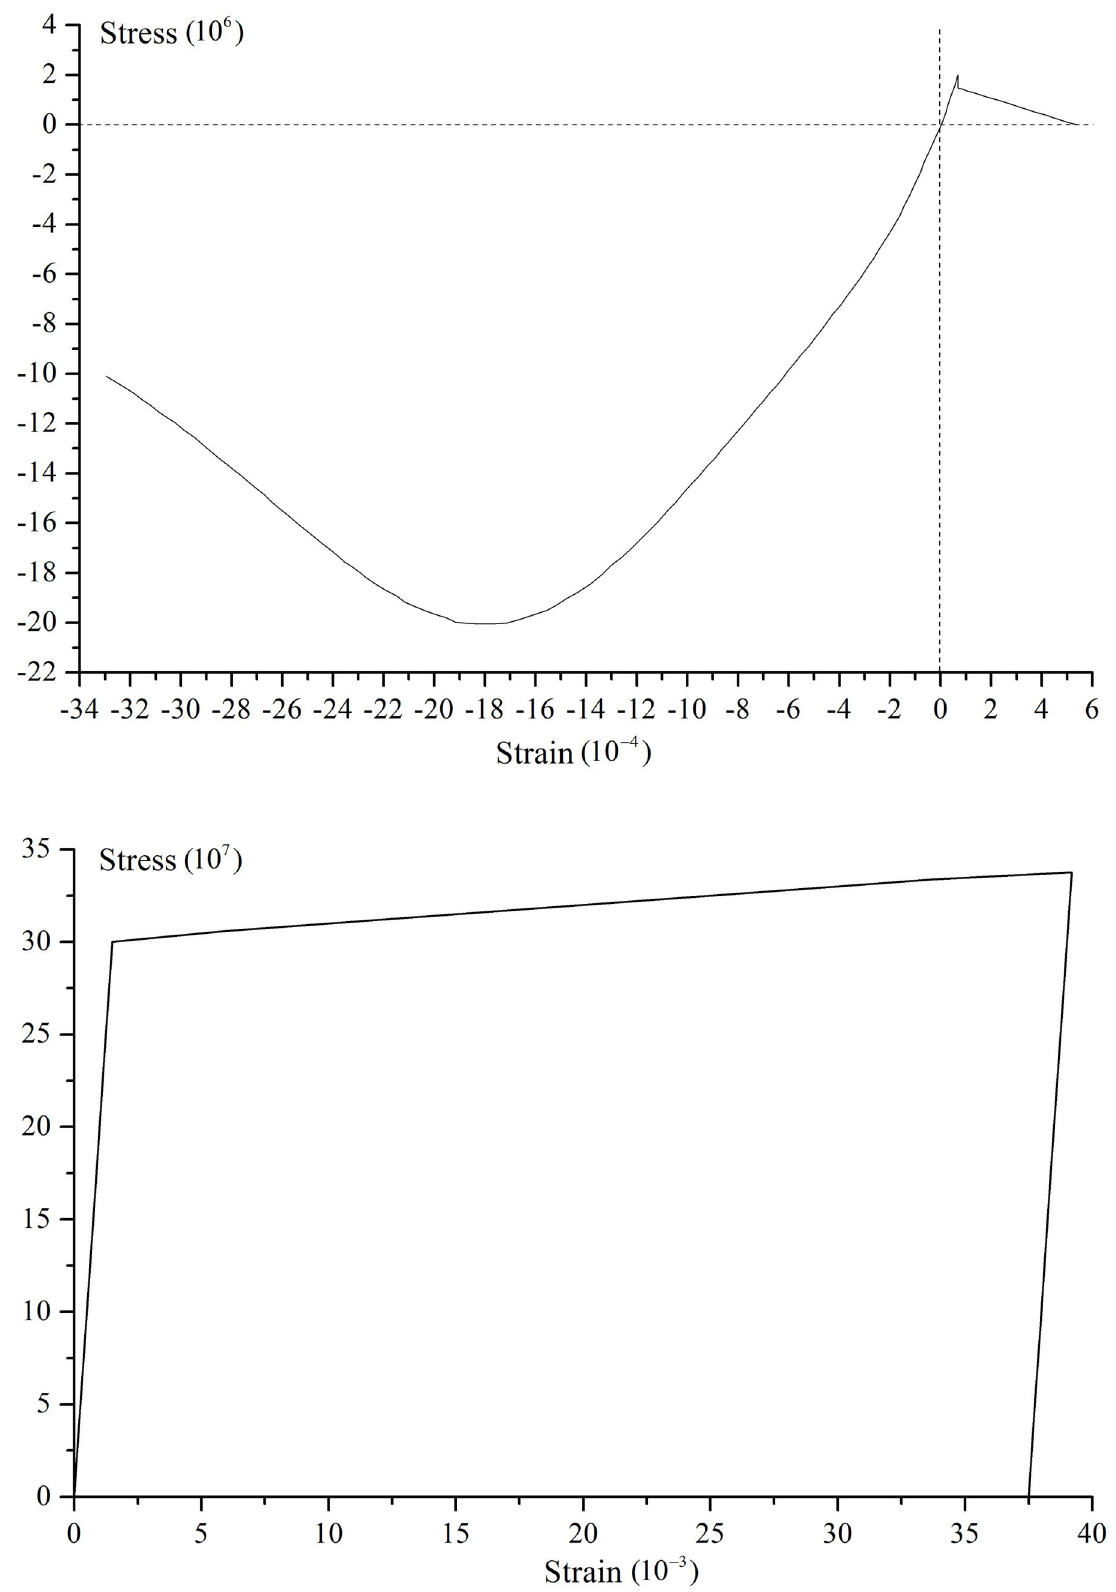
Fig 5. The stress-strain curve of the materials in the numerical simulation. a) The concrete. b) The reinforcement.